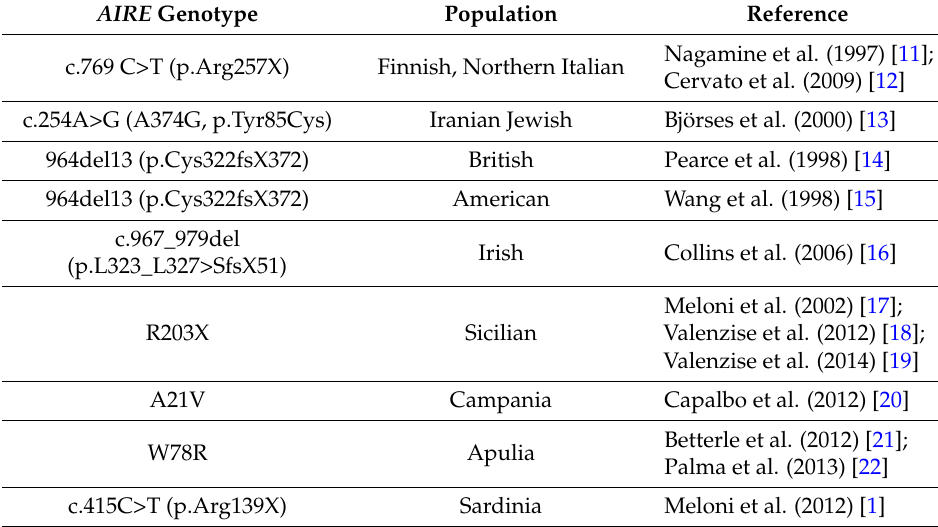
Table 1. AIRE peculiar genotypes in certain